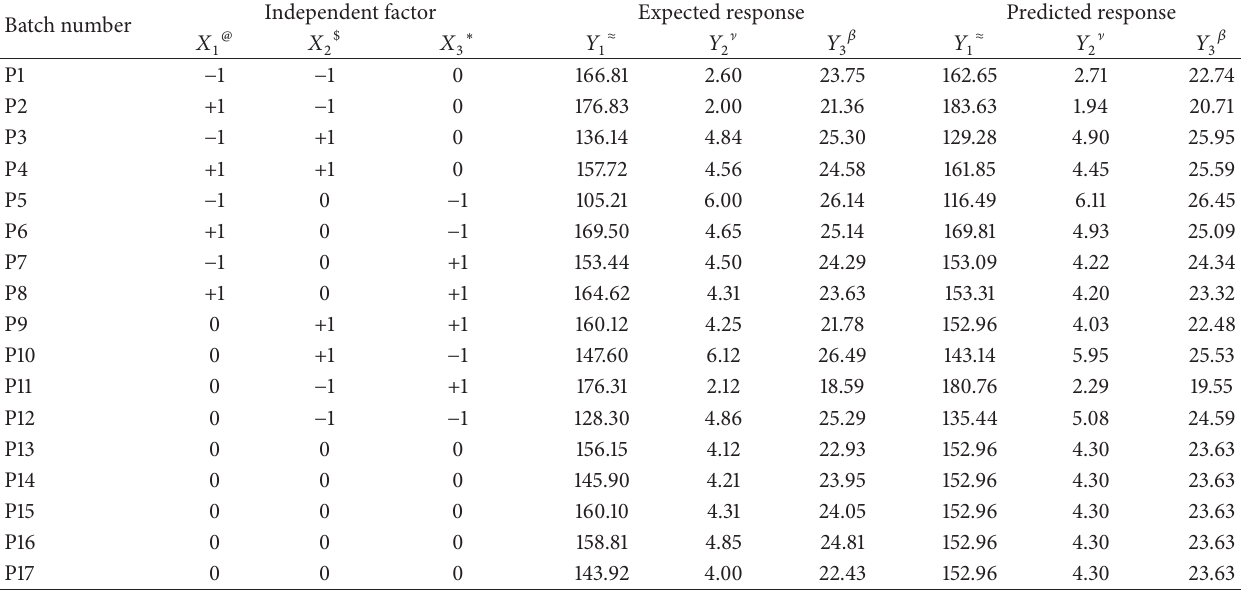
Table 3: Combination levels of independent variables and the outcome of response variables by Box-Behnken design. Independent Batch number